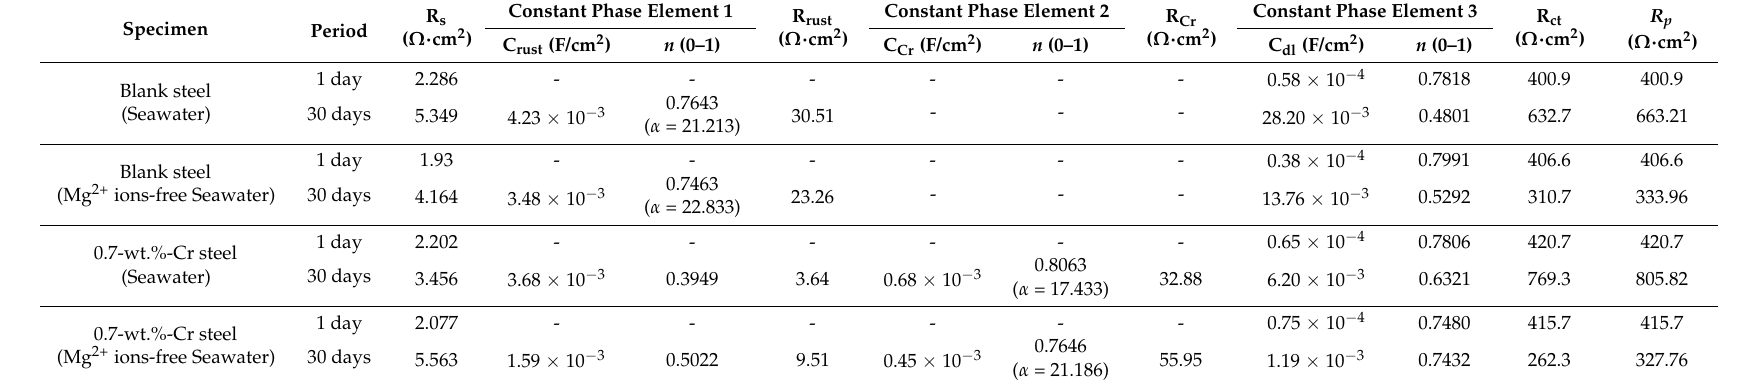
Table 1. EIS parameters of the specimens immersed in 60 ◦ C seawater for 1 day and 30 days under an aerated